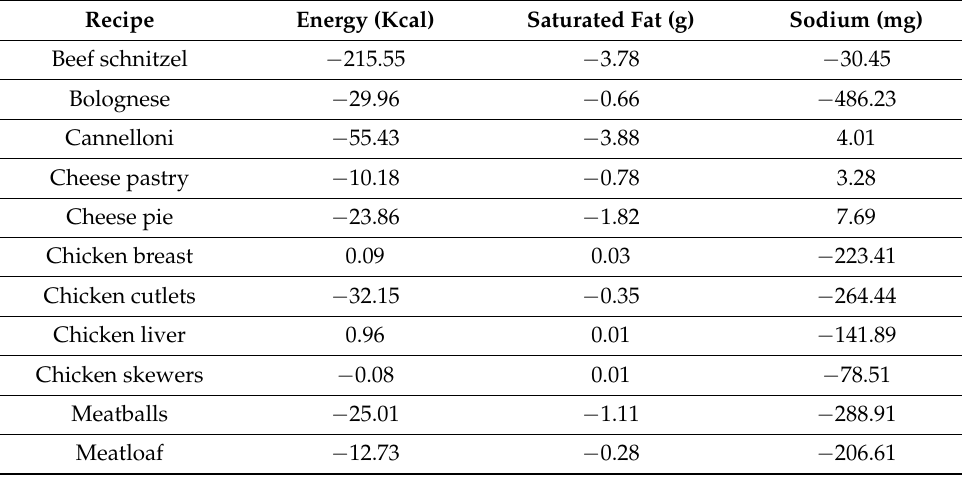
Table 1. Nutrient change per 100 g following recipe